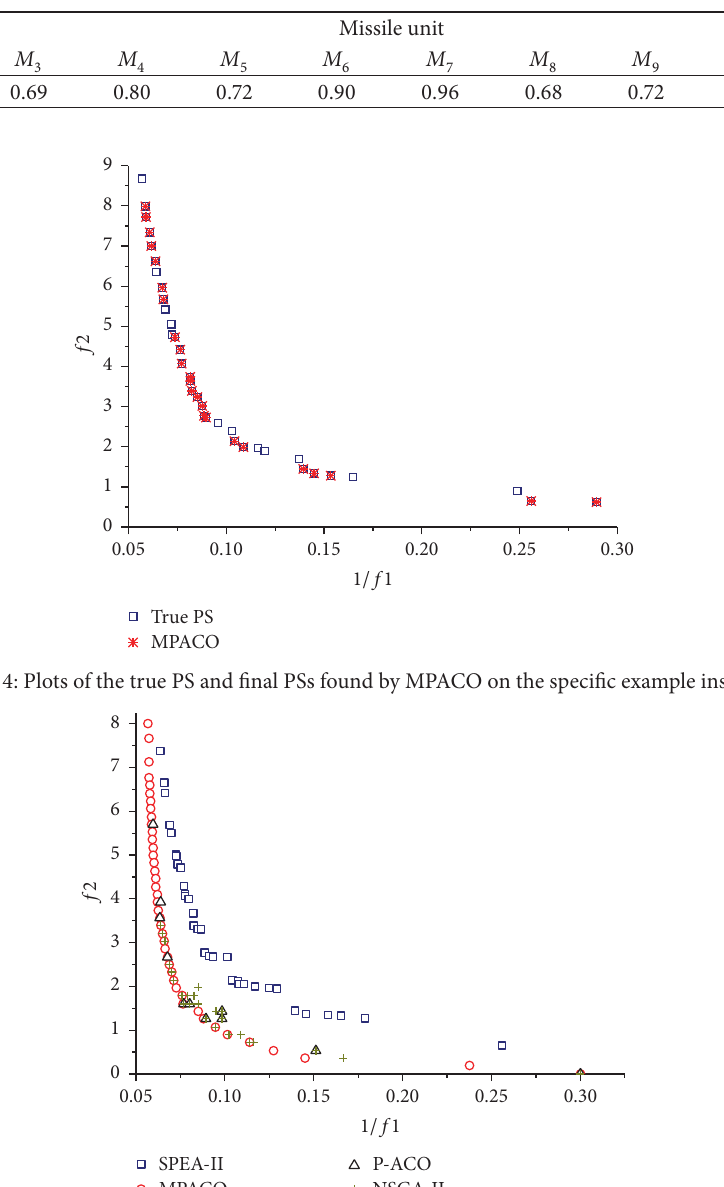
Table 7: The cost of each missile table.